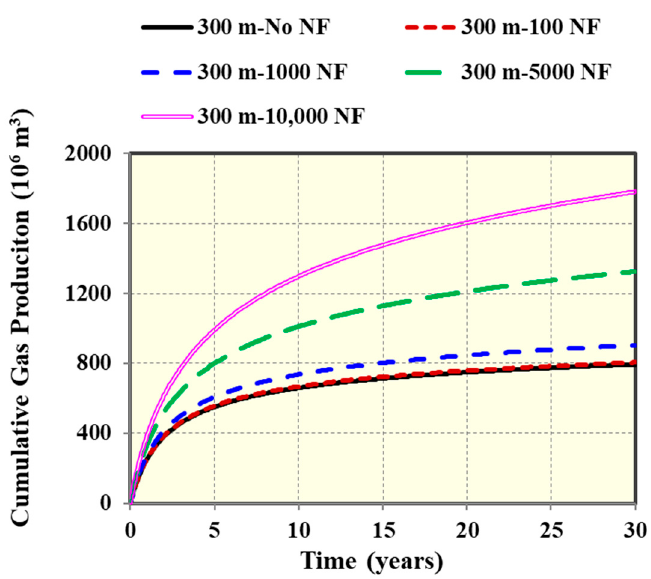
Figure 9. Effect of different numbers of natural fractures on cumulative gas production for the reservoir model with well spacing of 300 m (NF in the legend represents natural fractures).